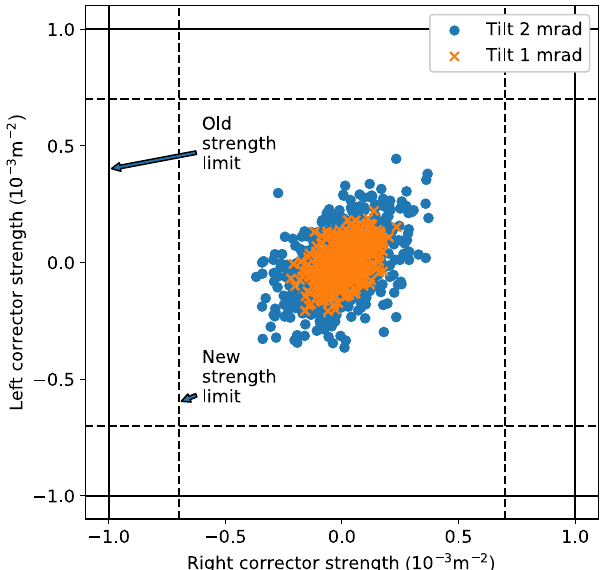
FIG. 7. Required strength of the skew quadrupole correctors in IR1 to cancel the coupling produced by 500 seeds of random tilts of (cid:3) 1 mrad and (cid:3) 2 mrad in Q4-5 and the triplet quadrupoles. The solid lines show the old specification for the strength limit of the correctorsandthedashedlinesthenewspecificationsetbythiswork.